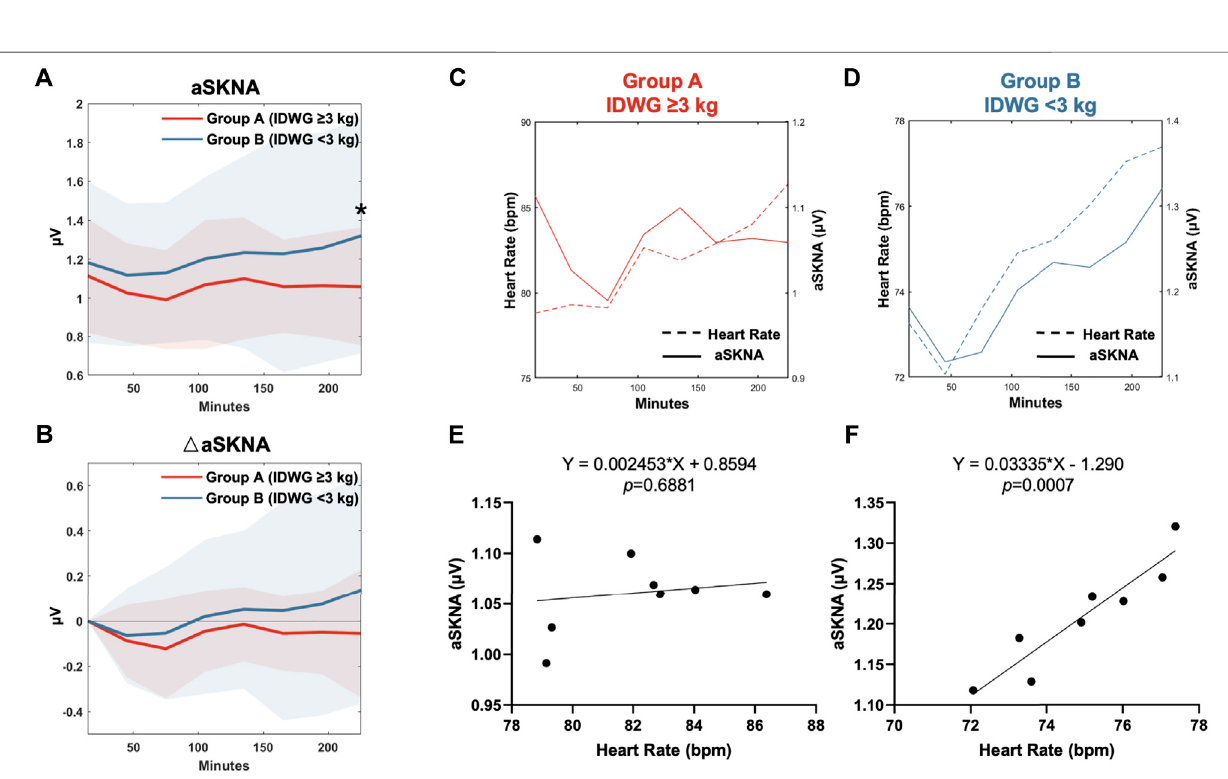
FIGURE3| HR-aSKNAcorrelationbetweenGroupA(IDWG ≥ 3 kg)andGroupB( < 3 kg). (A , B) SubgroupanalysisshowedaSKNA (A) andthedifferenceofaSKNA tothebaselinein0 – 30 min( △ aSKNA) (B) .TheaSKNAin210 – 240 minwassigni fi cantlyhigherinGroupB(IDWG < 3 kg). “ * ” standsforstatisticallysigni fi cant( p < 0.05)by Student ’ s t test between two subgroups. (C , D) The relationship of HR and aSKNA in Group A (C) or Group B (D) was demonstrated in eight periods (0 – 30, 30 – 60, 60 – 90,90 – 120,120 – 150,150 – 180,180 – 210,210 – 240 min). (E , F) TherewasnoHR-aSKNAcorrelationobservedinpatientsinGroupA( E , p =0.688).Instead,a linear correlation was found in Group B ( F , p <